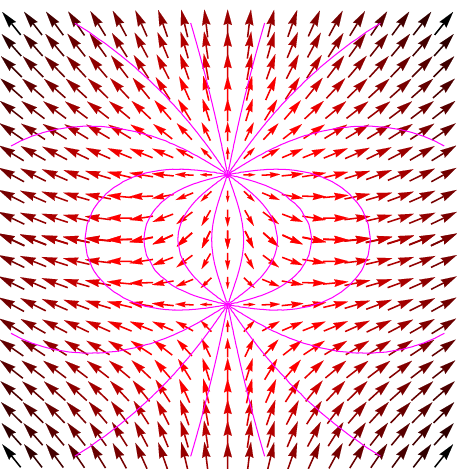
Figure 3. Schematic diagrams for the Q -field (arrows) and the flux lines (lines) of two opposite unit charges, Z = Q el = 0. The configurations are rotational symmetric around the axis through the two charge centers. The red/green arrows symbolise values of (cid:126) q = (cid:126) n sin α for postive/negative values of q 0 = cos α . For q 0 → 0 the arrows are getting darker or black. The left configuration belongs to the topological quantum numbers Q = s = 0 and the left one to Q = s = 1. Observe that field lines connect points of constant (cid:126) n -field.